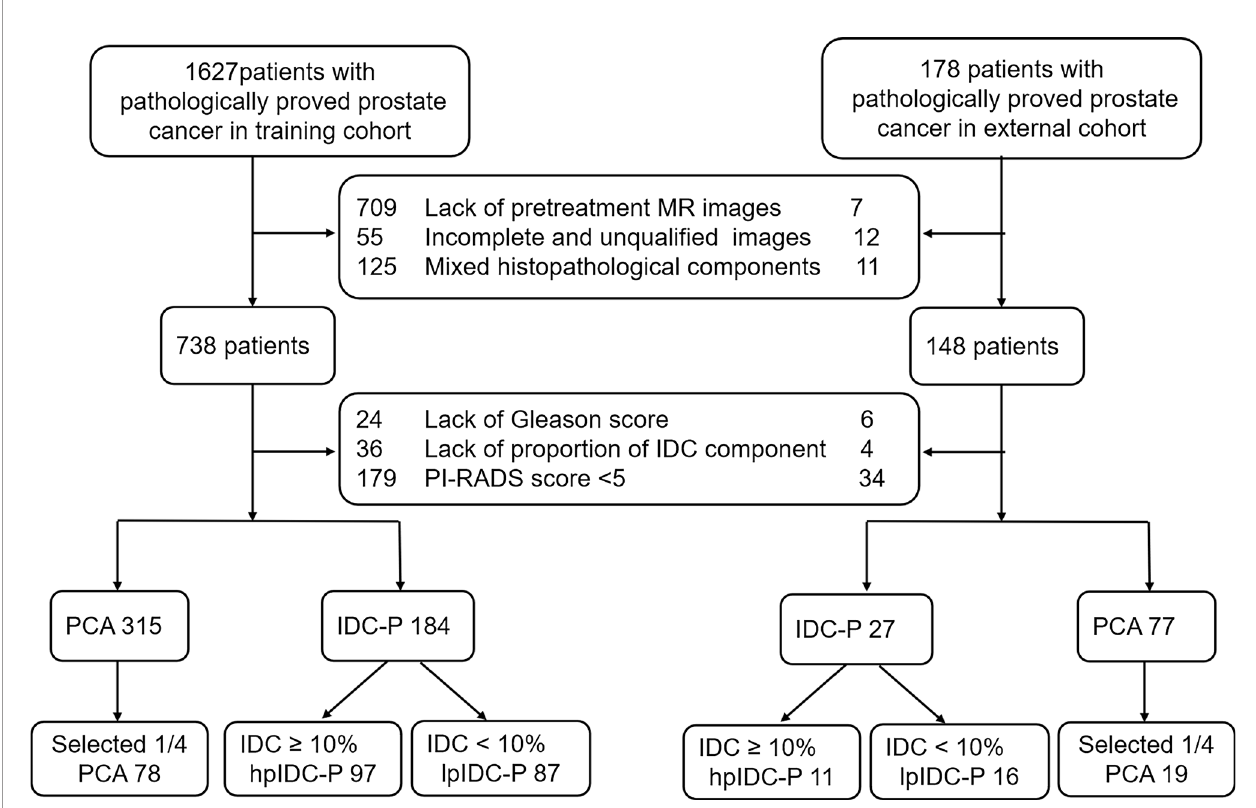
FIGURE 1 | Diagram for the patient selection process. IDC, intraductal carcinoma; PAC, prostatic acinar adenocarcinoma; PI-RADS, Prostate Imaging Reporting and Data